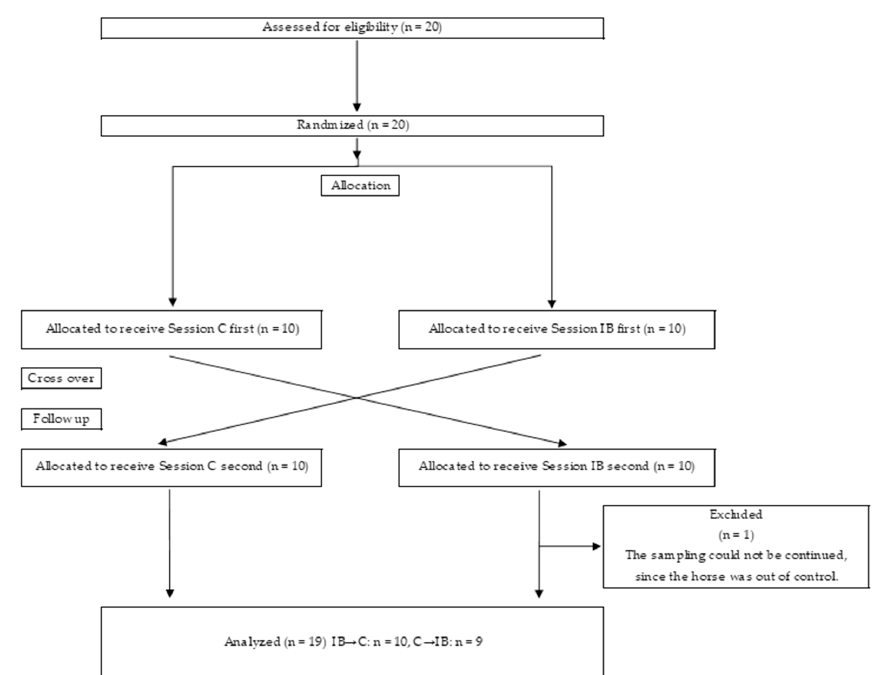
Figure 2. Flow diagram of the cross-over trial.